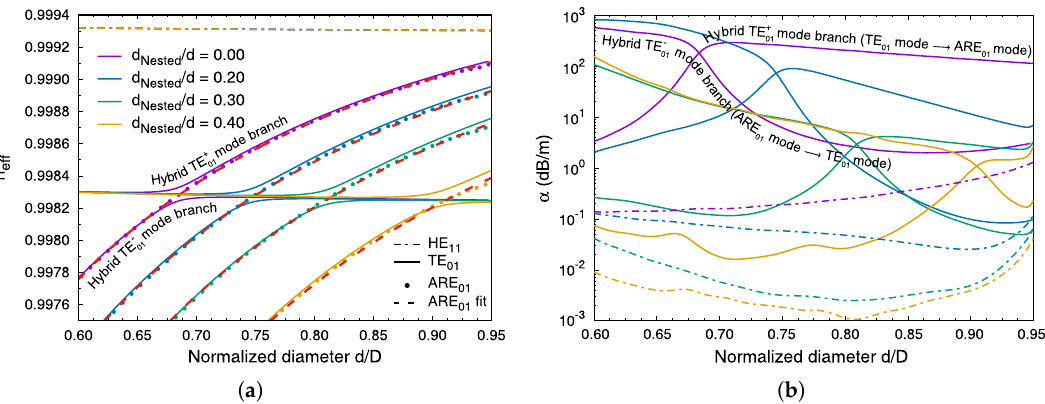
Figure 2. Numerically computed modal properties d / D dependence for different values of d Nested / d with t / D = 0.01 and D / λ = 20. ( a ) Effective indices of the fundamental HE 11 core mode (dot dashed curves), hybrid TE + and TE − modes (solid curves) and ARE 01 air-capillary mode (dotted curves). 01 01 The red dashed curve for each d Nested / d value represents the effective index of the ARE 01 mode of an isolated capillary, using the analytic model. ( b ) Corresponding mode confinement